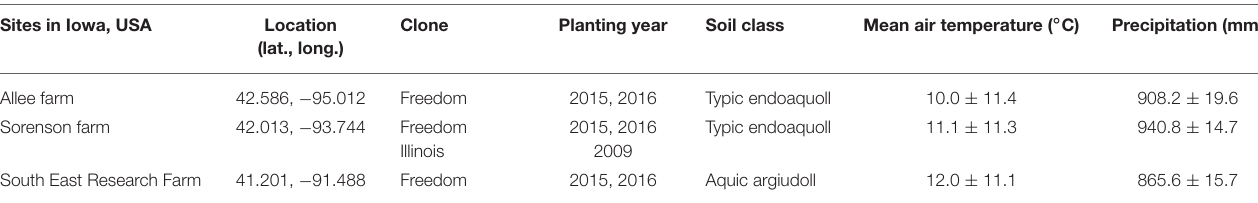
TABLE 1 | Overview of locations and plant material used to refine Miscanthus × giganteus morphological development descriptions for the BBCH scale. Sites in Iowa, USA Location (lat., long.)